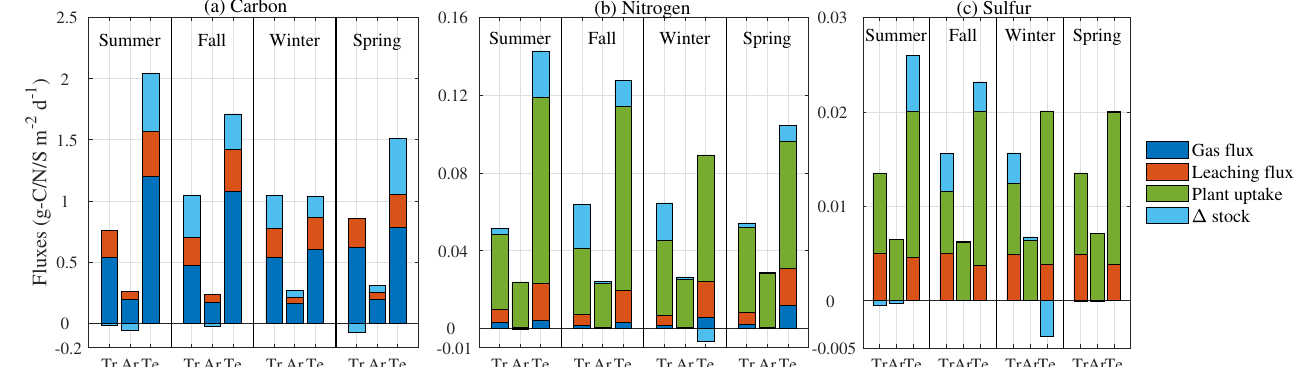
Figure 3. Inputs partitioned into fluxes of ( a ) carbon, ( b ) nitrogen, and ( c ) sulfur expressed as gas emission, nutrient leaching, plant uptake, and change in soil pool size (aqueous and protected phases, here labeled as ∆ stock). Tr, Ar, and Te represent tropical, arid, and temperate regions, respectively. The bars (total of all fluxes) represents the C, N, and S input. Fluxes are expressed as grams of element per unit surface area of wetland per